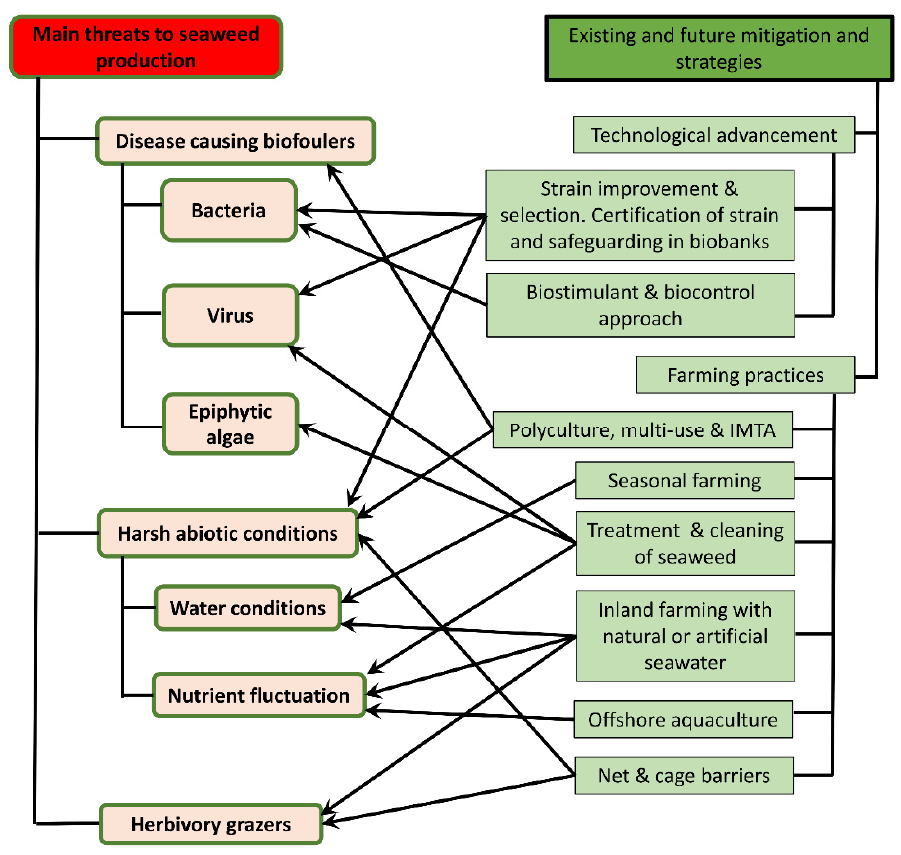
Figure 2. The main threats to seaweed production and their mitigation